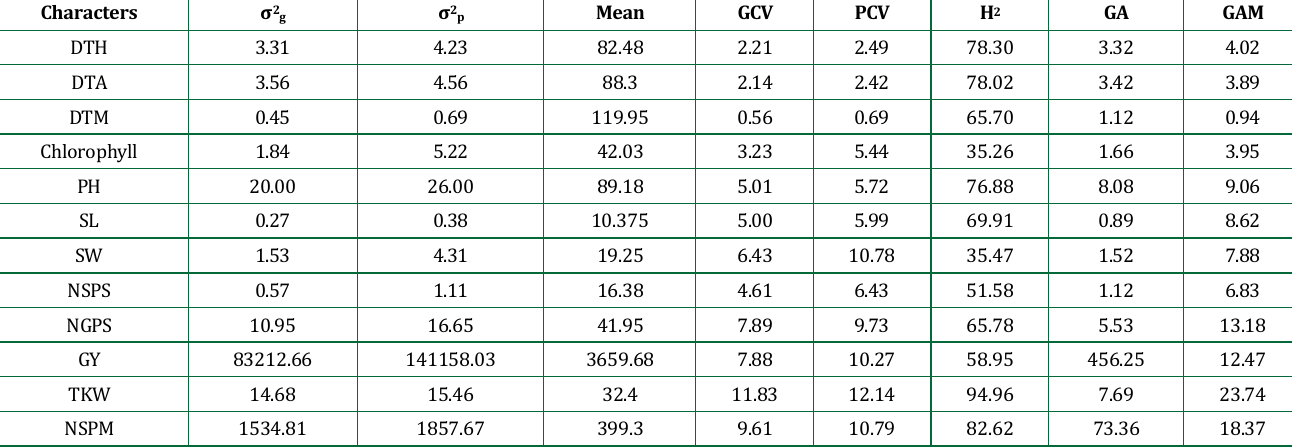
the mean for 12 characters.